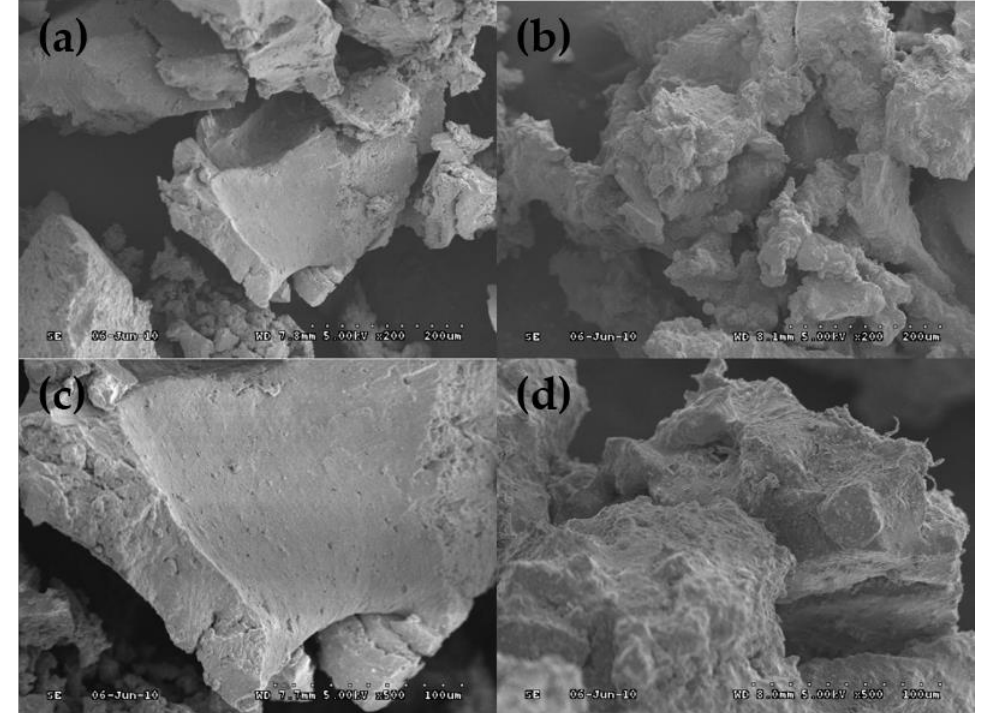
Figure 2. Scanning electron microscopy (SEM) images of CR and AM–CR. ( a ) The image of CR (200×); ( b ) The image of AM–CR (200×); ( c ) The image of CR (500×); ( d ) The image of AM–CR (500×).